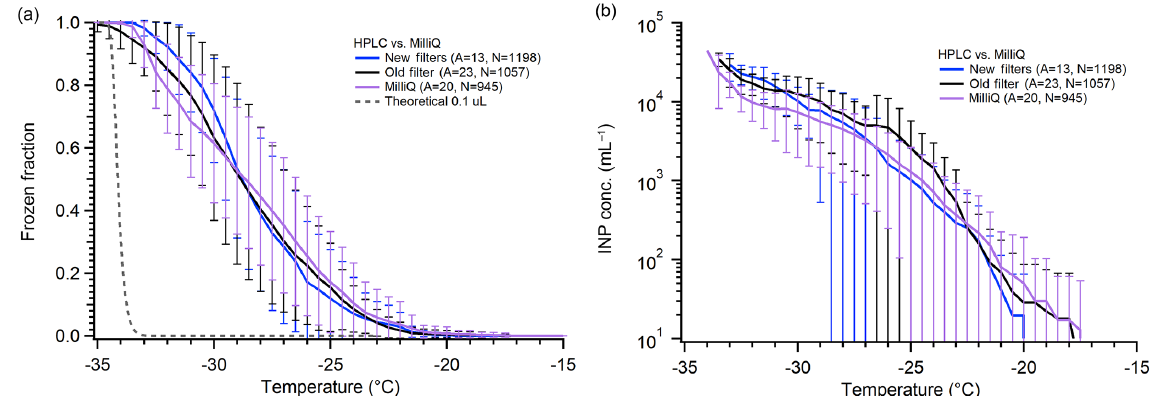
Figure 3. Comparison of pure water freezing using filtered MilliQ-produced water and filtered purchased HPLC water. Shown are the measured droplet freezing temperature spectra (a) and the derived INP concentration (b) . HPLC water was filtered using a new Anotop 0.02µm filter for each bottle of water (blue), or the same filter for multiple stock bottles of water (black). The results from typical MilliQ water arrays are shown in purple. The parentheses next to each legend entry contain the number of arrays of droplets ( A ) and the total number of droplets across all arrays ( N ). The gray dashed line indicates the theoretical homogeneous freezing curve of 0.1µL droplets, using the parameterization of Koop and Murray (2016).